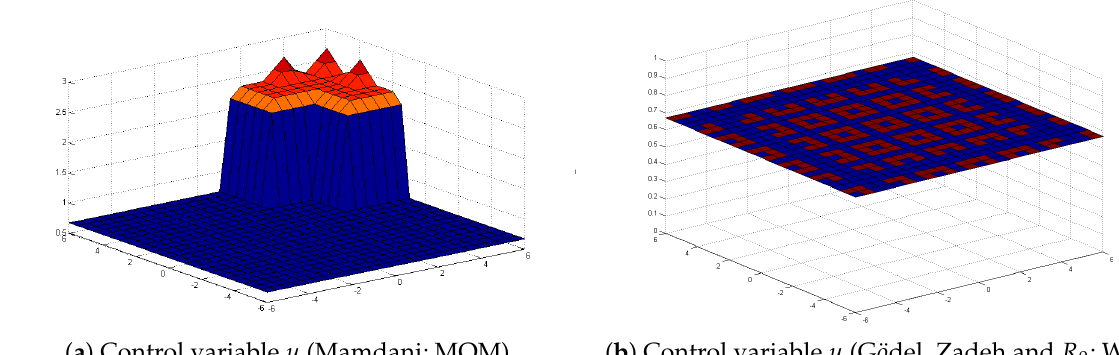
Figure 5. Inference results of triple I